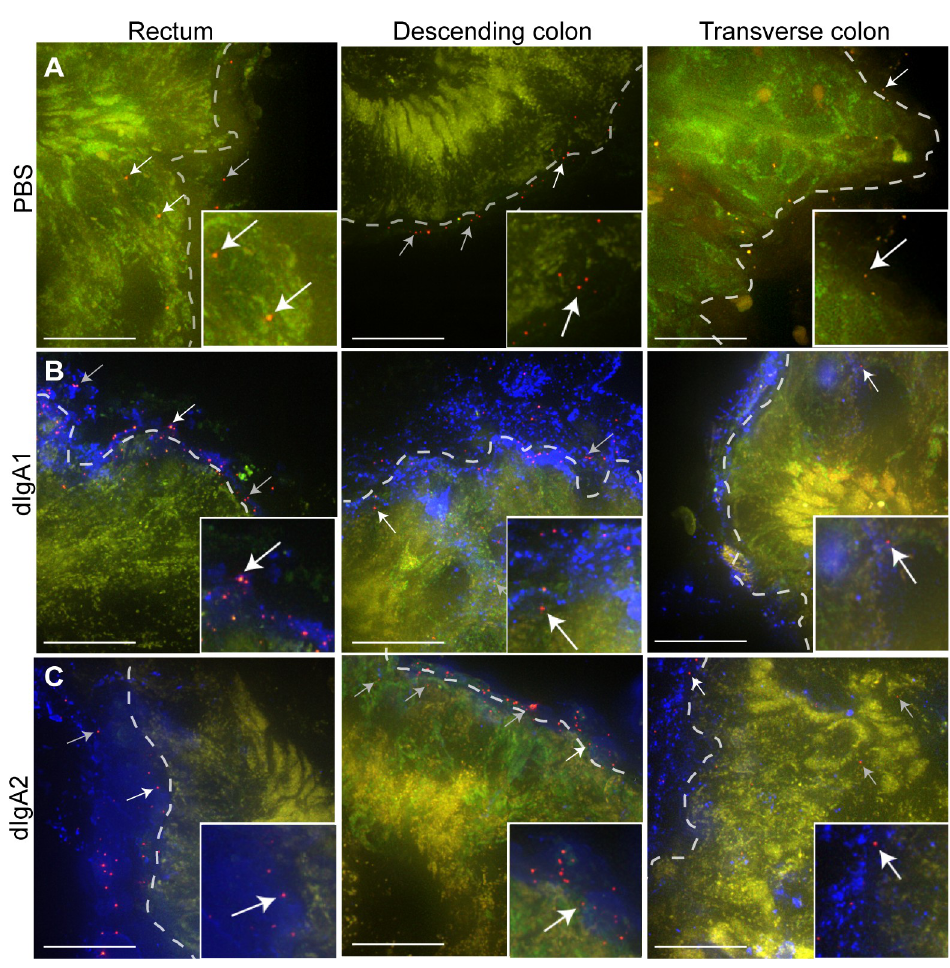
Fig 3. HIV Virion penetration two hours post-rectal challenge. Three animals were challenged rectally with PBS, dIgA1-Cy5 or dIgA2-Cy5 and a mixture of PA-GFP-BaL and PA GFP-BaL 64 Cu ( Table 1, protocol 3). Two hours later, animals were sacrificed, tissues dissected, frozen and tissue blocks with intense PET signal (virion) were cryosectioned. Representative fluorescent microscopy images. Red, GFP/HIV virion (post-activation); blue, dIgA; green, autofluorescence (pre-activation). ( A ) PBS negative control ( B ) dIgA1-Cy5. ( C ) dIgA2-Cy5. White arrows indicate HIV virions shown in insets; grey arrows show other viral particles in micrograph. A dashed line in each panel demarcates the edges of the epithelium. Scale bars, 20 μ